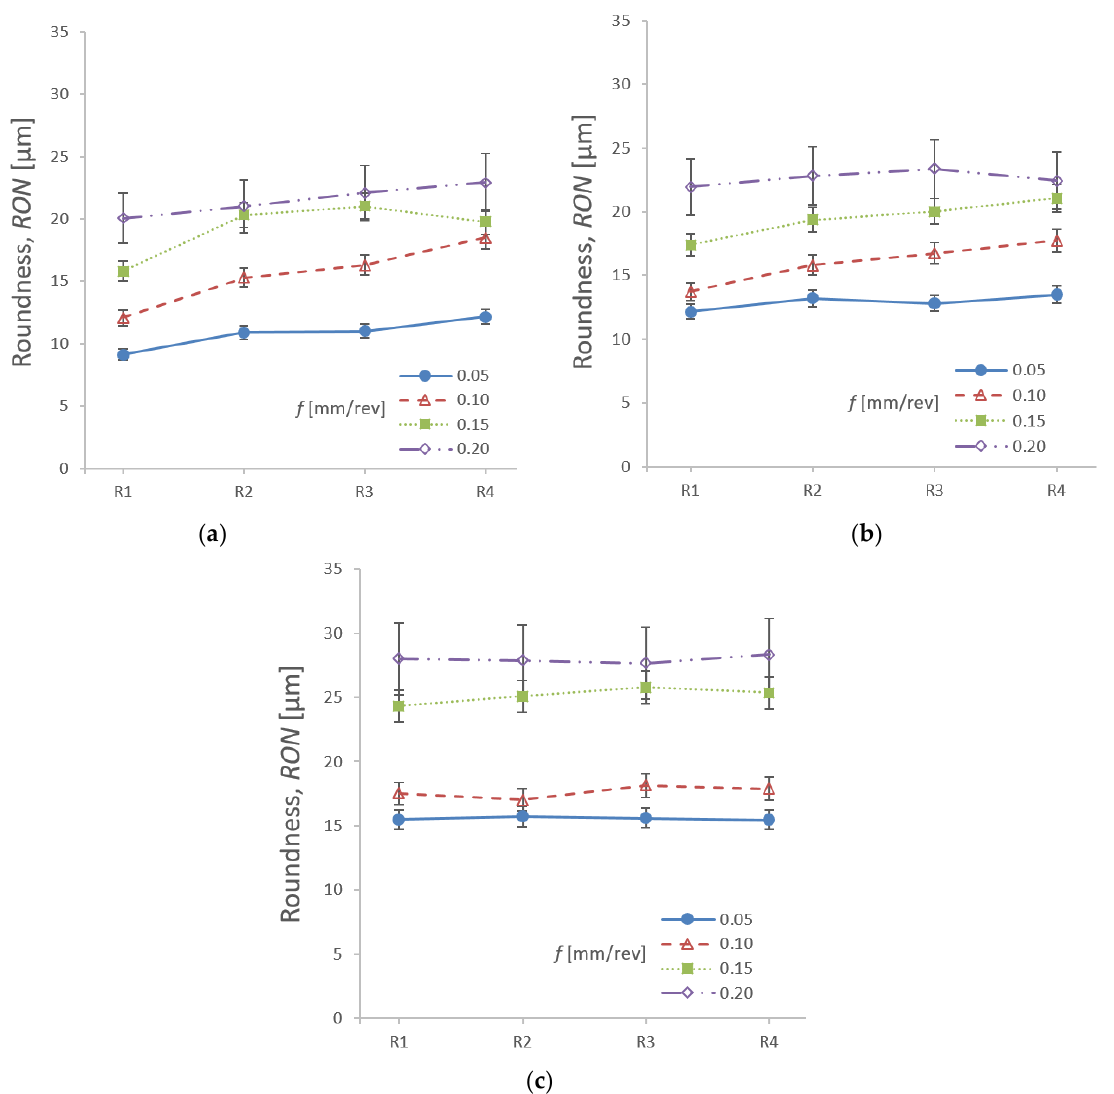
Figure 14. Roundness evolution for each repetition ( Ri ) as a function of f , for: ( a ) v c = 40 m/min; ( b ) v c = 60 m/min; ( c ) v c = 80 m/min.